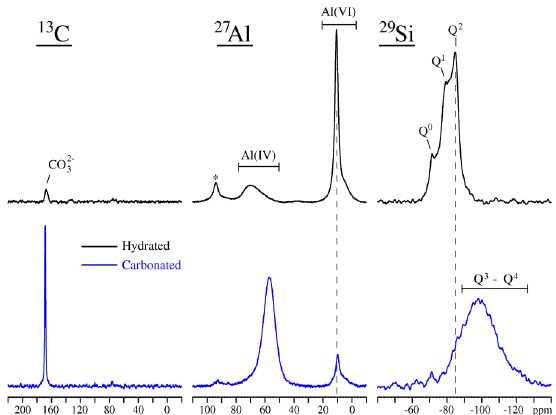
Figure 3. 13 C, 27 Al and 29 Si NMR spectra of a hydrated Portland cement (CEM-I) paste before and after enforced carbonation (360 min.), acquired at 7.05, 14.09 and 7.05 T using spinning frequencies of 7.0, 13.0 and 7.0 kHz, respectively. The 13 C NMR spectra show the formation of a significant amount of CaCO 3 . The 27 Al NMR spectra clearly differentiate Al in tetrahedral (Al(IV)) and octahedral (Al(VI)) coordination. Al(IV) is found in the C-(A)-S-H phase (hydrated) and shows resonances from belite (Q 0 ) and the C-(A)-S-H phase (Q 1 and Q